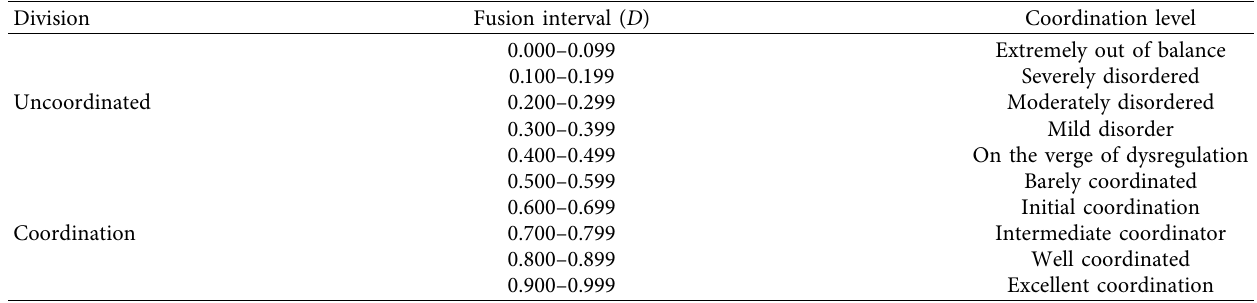
Table 3: Division of industrial integration evaluation index system.